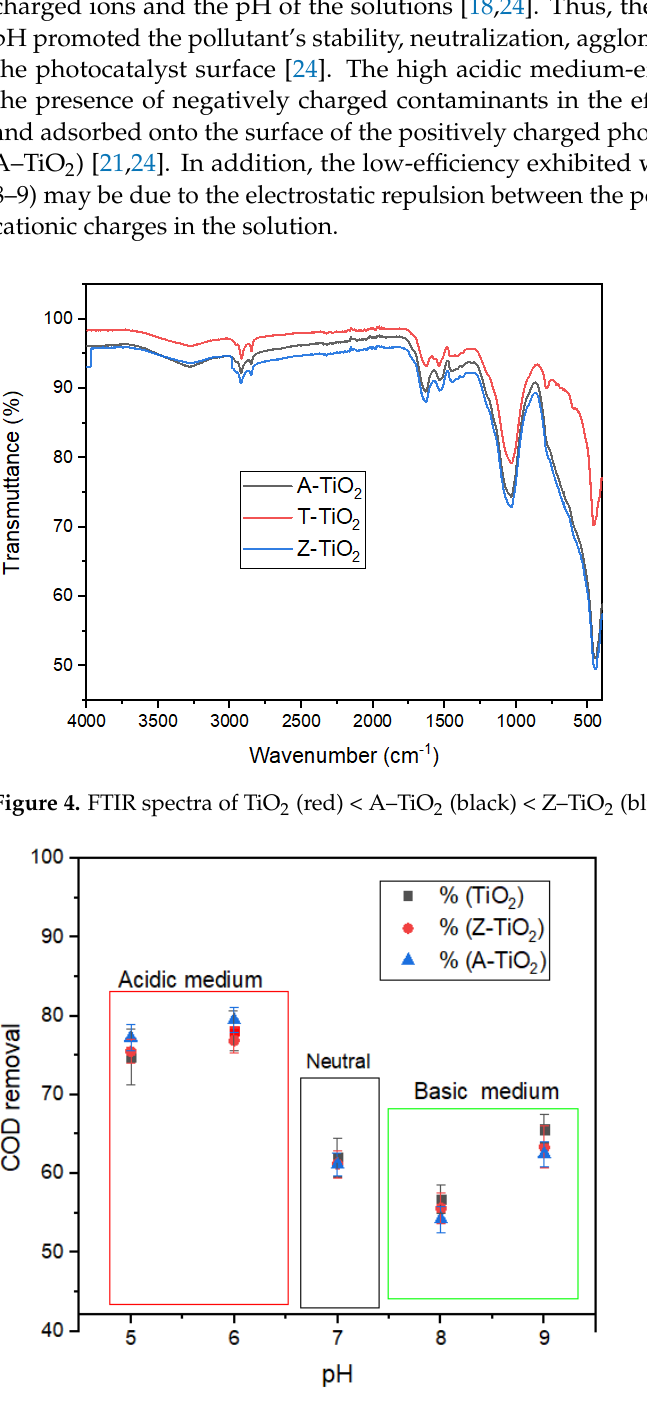
Figure 5. Effect of pH on photocatalytic degradation of chemical oxygen demand (COD) at a cata- lyst load of 2 g and reaction time of 30